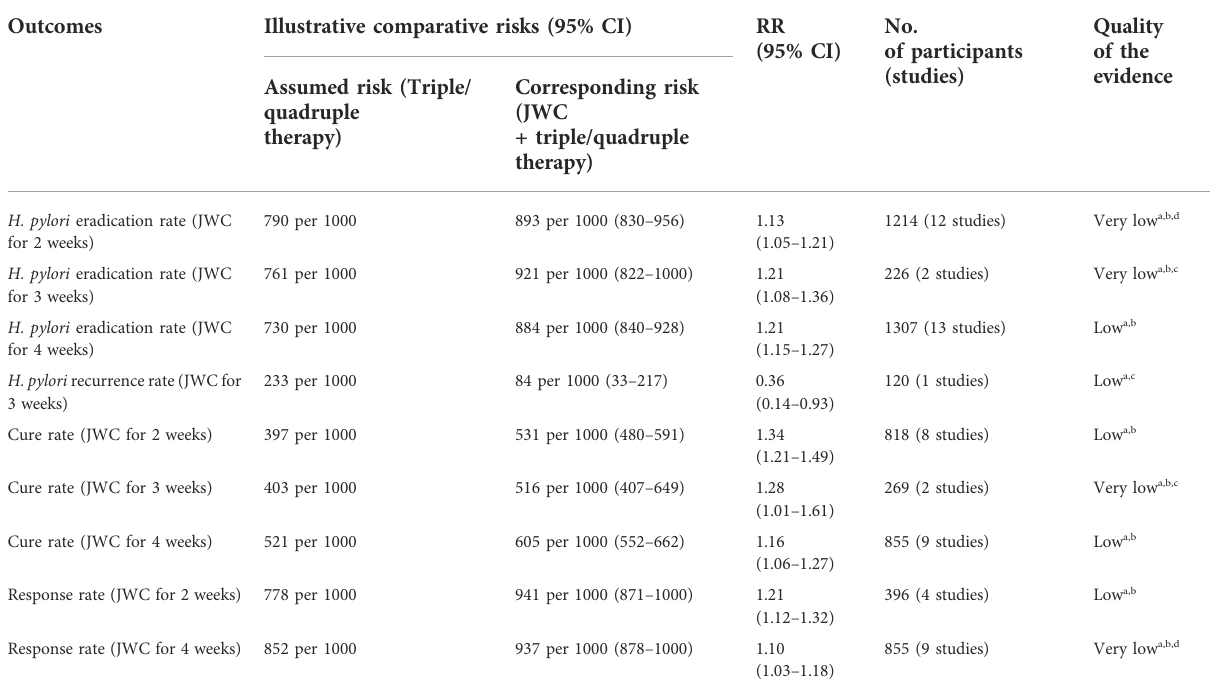
TABLE 3 GRADE quality of evidence summary